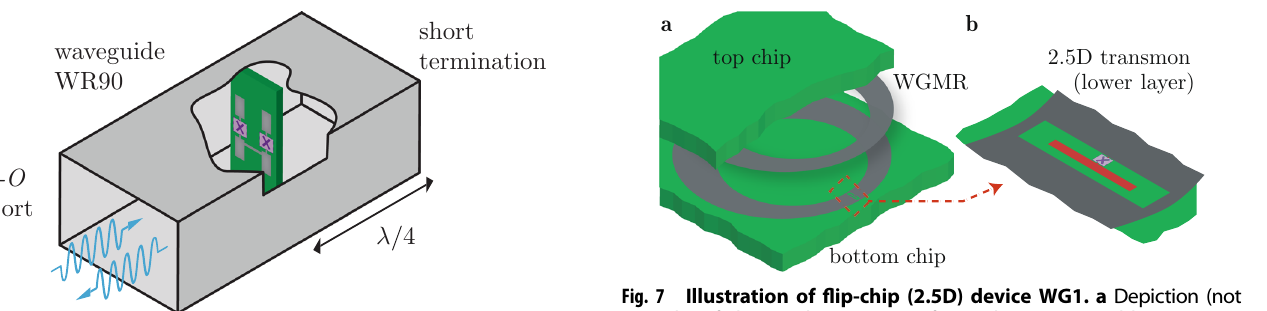
Fig. 6 Schematic representation (not to scale) of superconducting waveguide device DTW1. Two-qubit chip is placed λ /4 from a short termination in the waveguide. Guided input-output waves are launched and monitored through the I-O port connecting to a standard SMA adapter (not